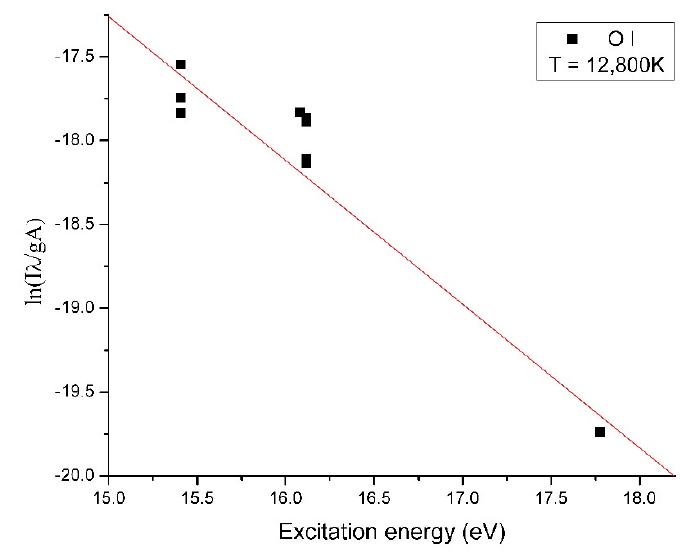
Figure 7. The Boltzmann plot and electron temperature for ions oxygen.